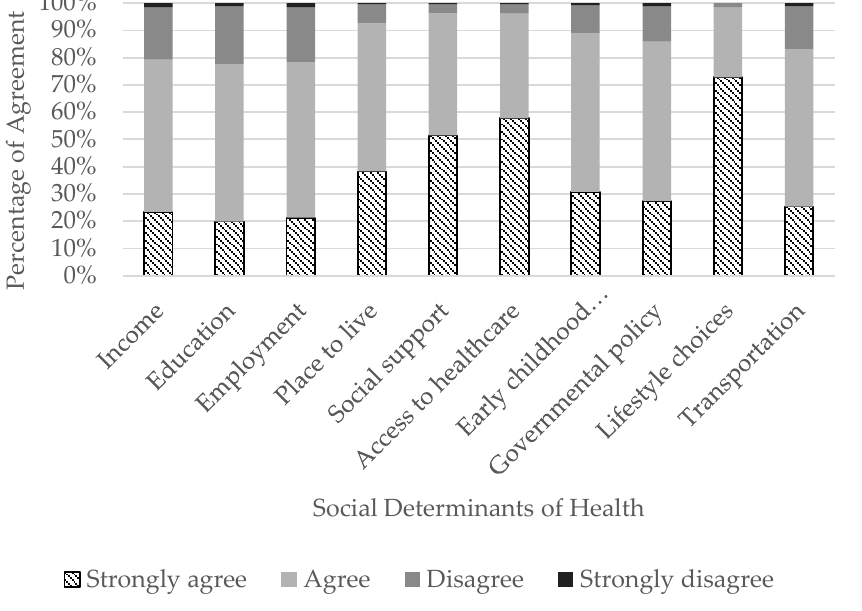
Figure 2. Athletic trainers’ perceptions of the influence social determinants of health have in athletic healthcare.